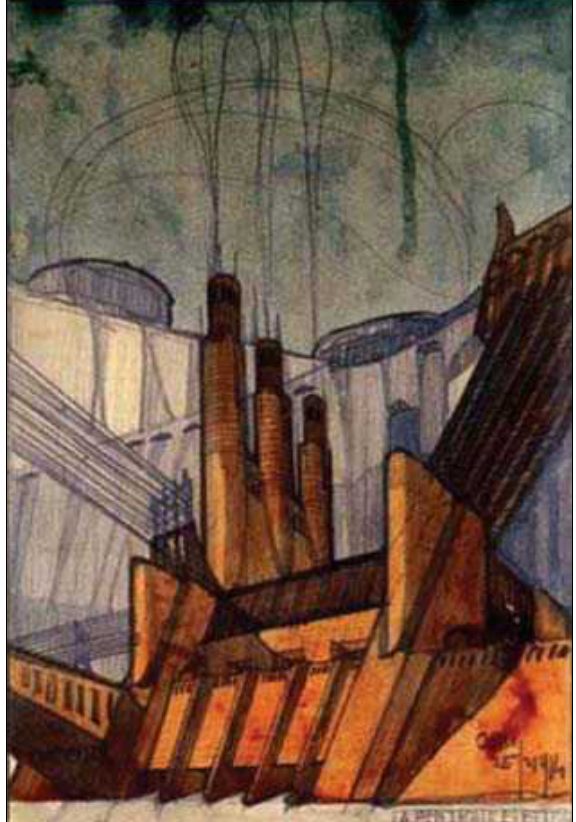
Fig. 1. central eletric Power